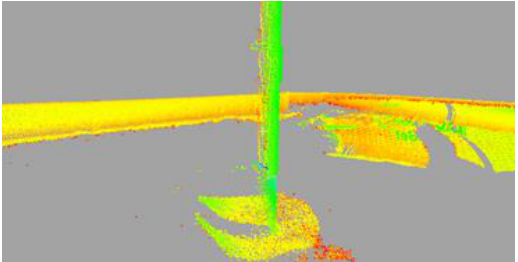
Figure 19. Three-dimensional laser scan after refraction correction for Trial 5 [36] (used with permission).